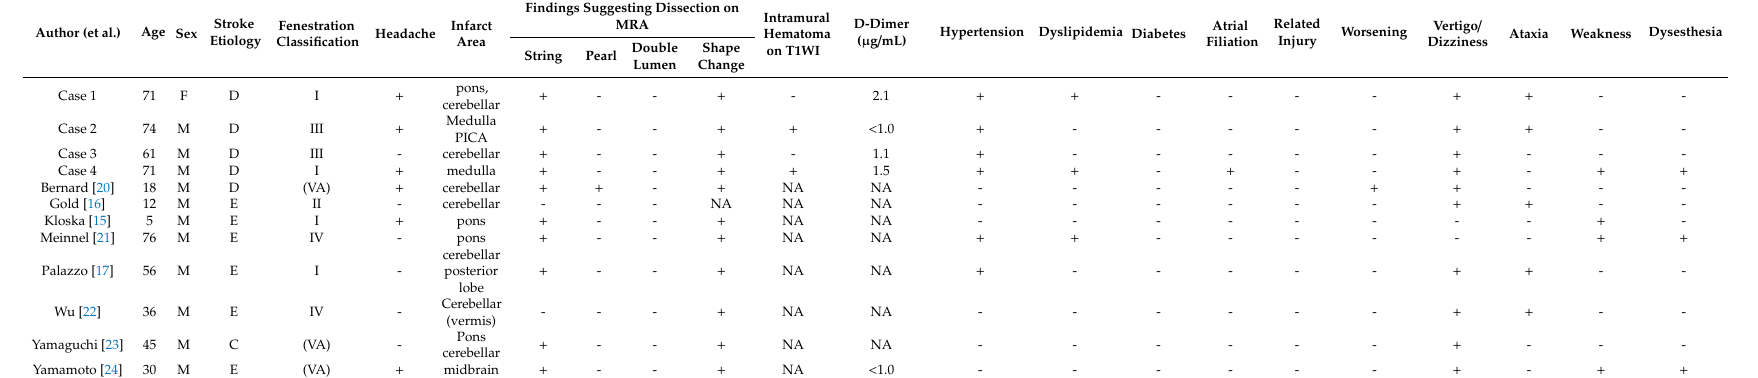
Table 1. Clinical features, vascular risk factors and radiological findings of vertebra-basilar artery-related